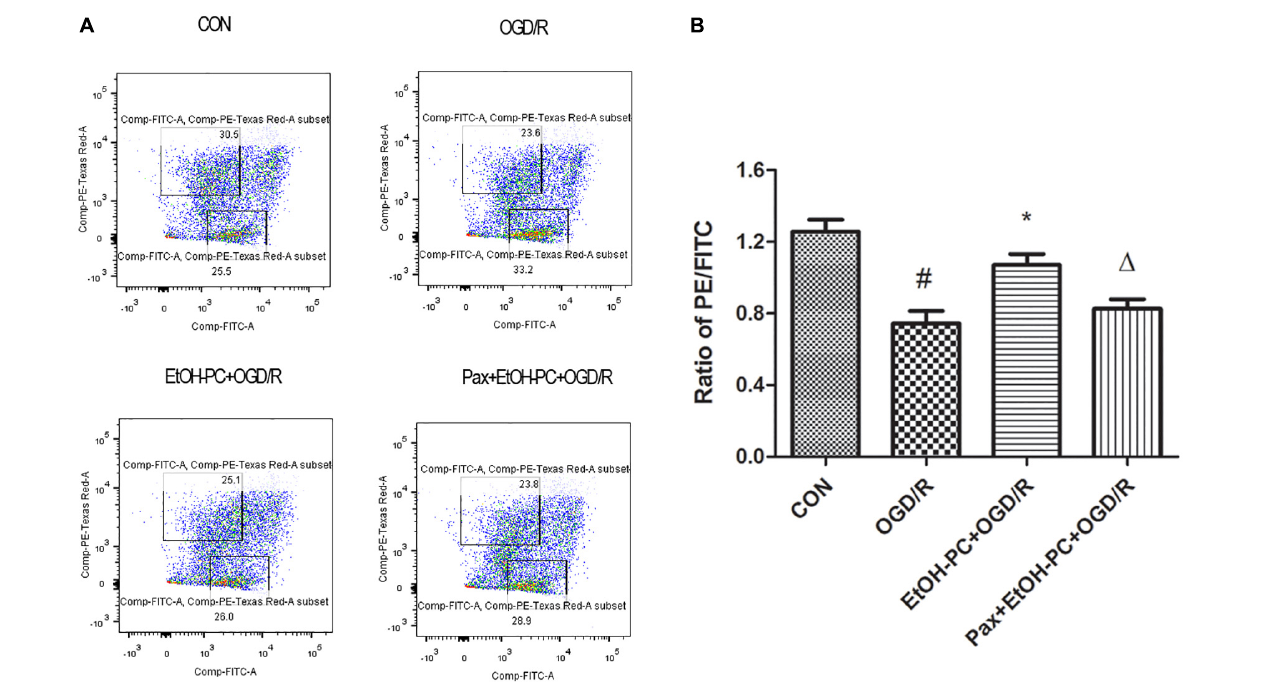
FIGURE 5 | Ethanol preconditioning increased the mitochondrial membrane potential through activating mitoBK Ca . After the neurons were preincubated with paxilline (5 µ mol/L) for 10 min and preconditioned with ethanol (10 mmol/L) followed by OGD2h/R24h, the neurons were incubated with JC-10 at 37 ◦ C for 30 min. Then, the cells were centrifuged, and the stained cells were subjected to flow cytometry assay (A) . Results are expressed as mean ± S.D. ( n = 5). # P < 0.01 vs. CON; * P < 0.05 vs. OGD/R; (cid:49) P < 0.05 vs. EtOH-PC + OGD/R (B) .